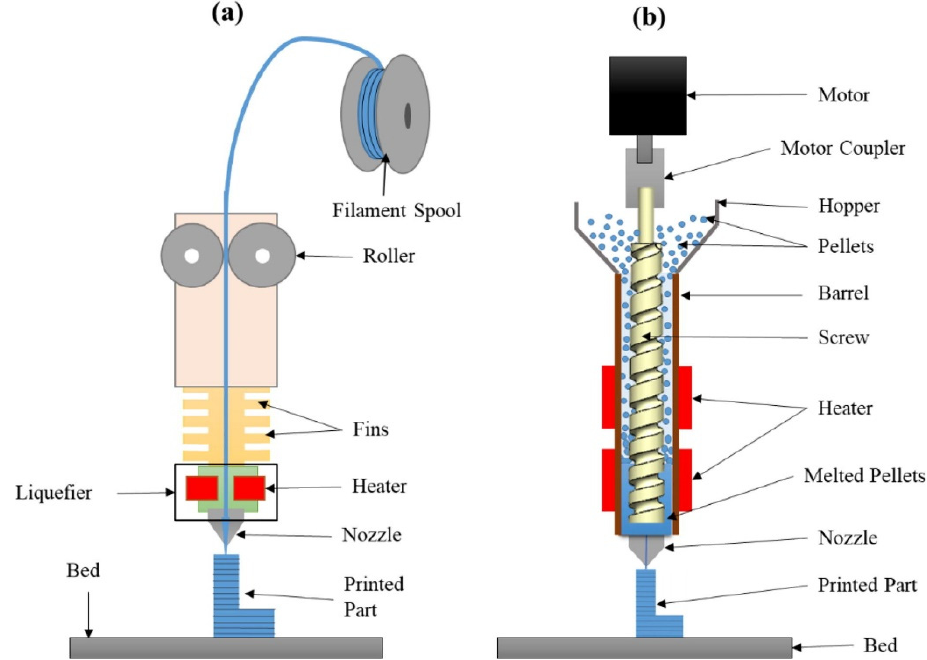
Figure 4. Schematic of ( a ) FFF process and ( b ) pellet extrusion process. Reprinted from [18] with permission from Elsevier.